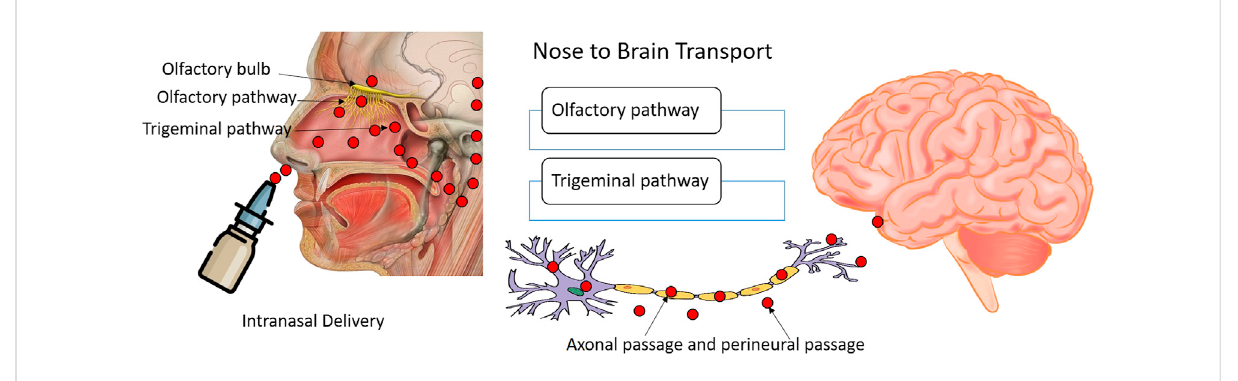
FIGURE 3 Intranasal administration of drugs to reach brain along the olfactory, trigeminal